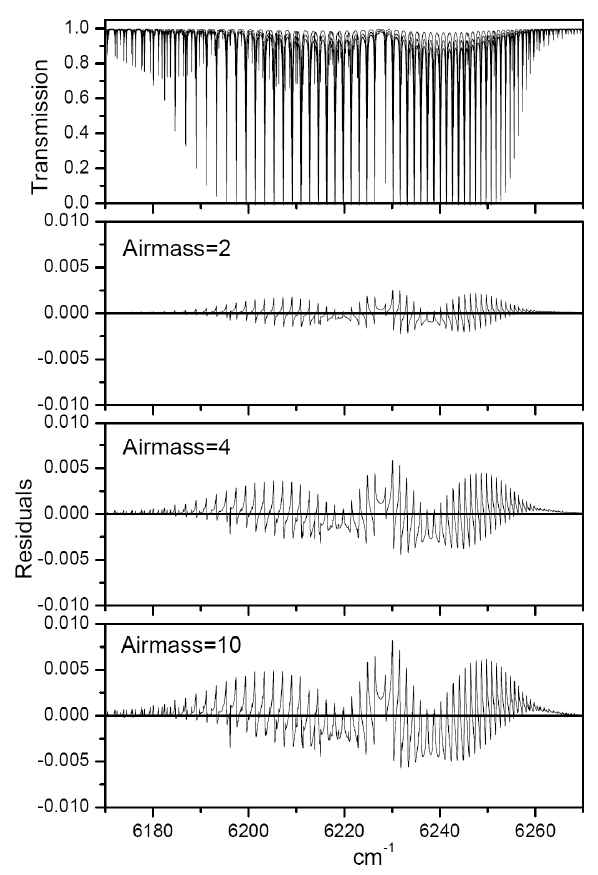
Fig. 7. Same as Fig. 6 but for Figure 7. Same as Fig. 6 but for Band#2.